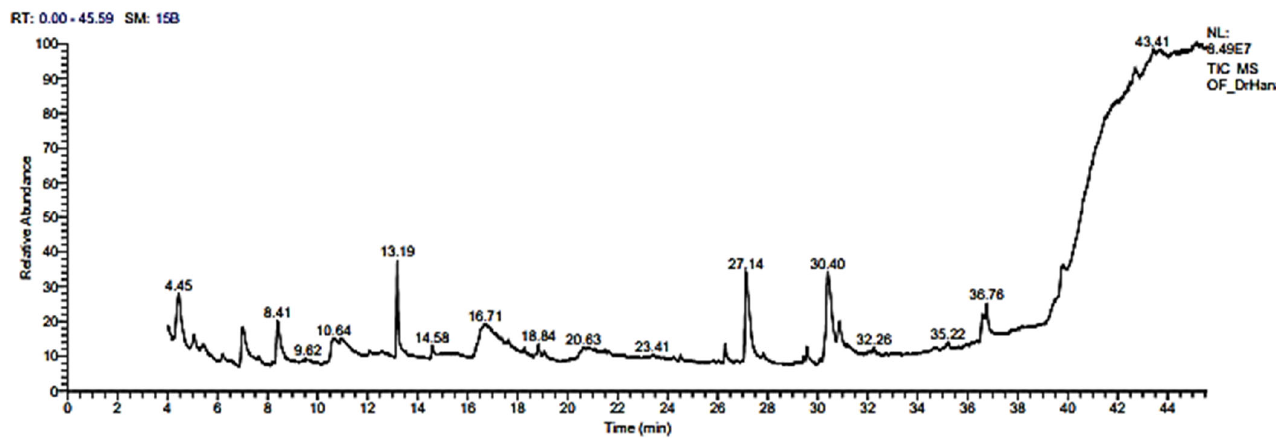
Figure 1. GC–MS analyses of the RCFE. Table 3. GC–MS analyses of the RCFE. Table 4. Bioactivity of major compounds in the